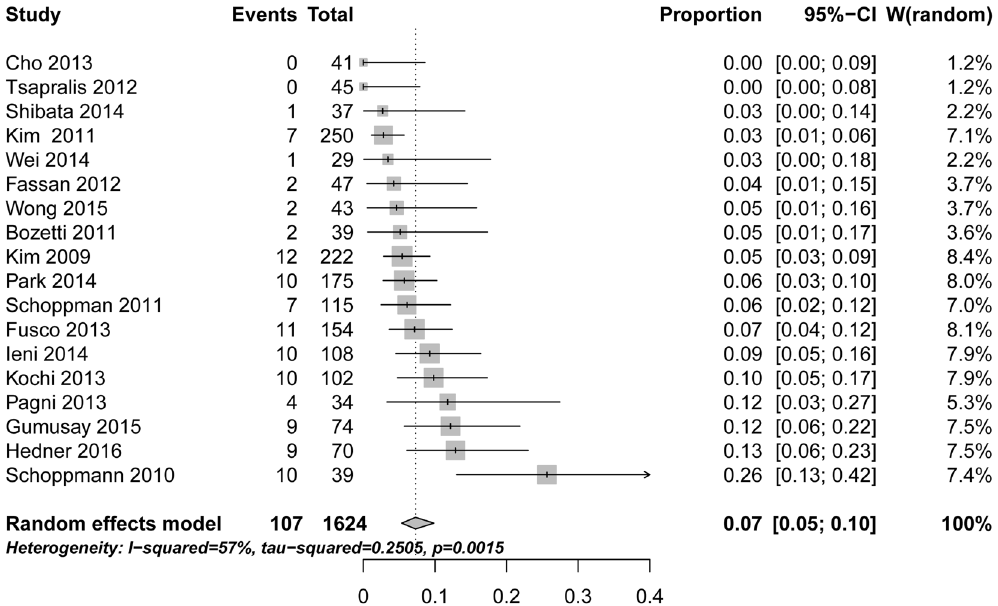
Figure 4. Random-effect single-arm meta-analysis of proportions of discordant HER2 status in gastro- esophageal